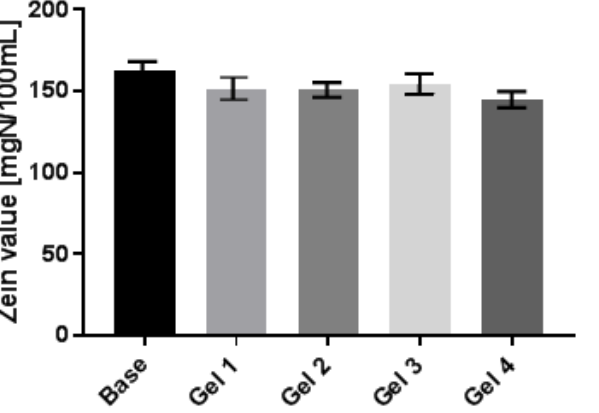
Figure 6. Inhibition of tyrosinase by four types of Schisandra chinensis fruits aqueous extracts (UAE-